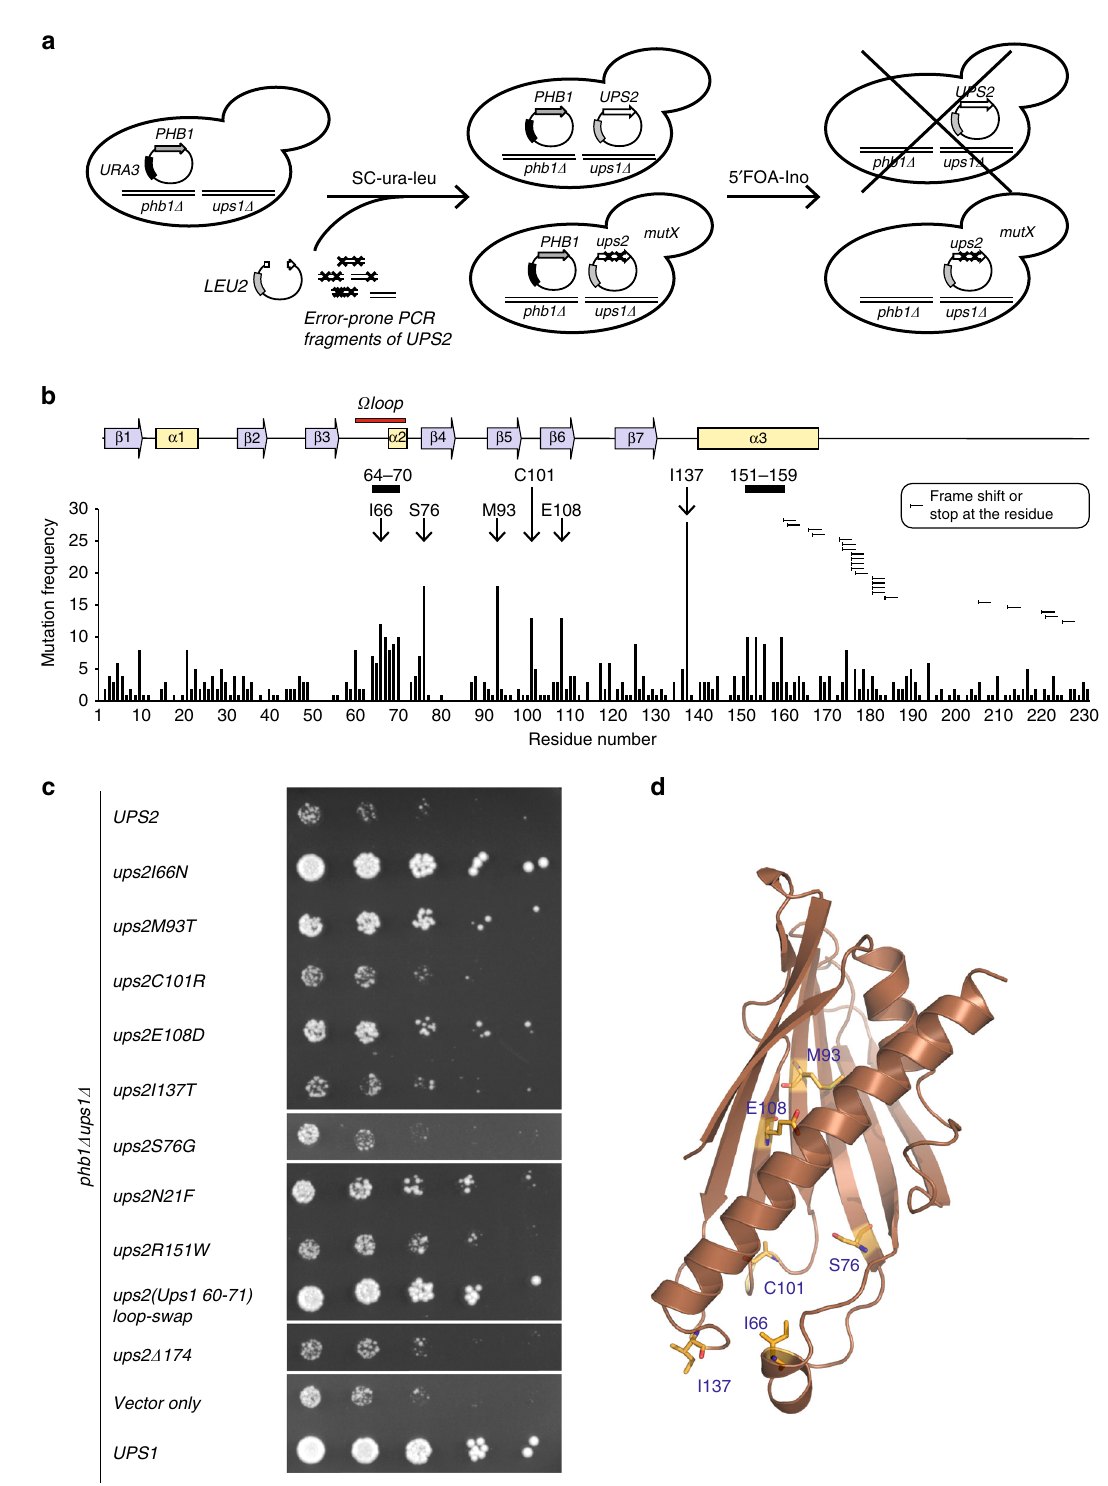
Fig. 5 Identi fi cation of Ups2 variants transferring PA. a Reverse genetic screen for Ups2 variants substituting for Ups1. ups1 Δ phb1 Δ cells harbouring plasmid-borne PHB1 and URA3 were transformed with a linearised yeast plasmid and with PCR fragments of the UPS2 gene that were ampli fi ed by error- prone PCR. The plasmid encoding URA3 was excluded from cells upon growth of the transformants in the presence of 5 ′ FOA. Cells were grown in the absence of inositol to further suppress the growth of the host strain. Plasmids encoding Ups2 mutants were isolated from growing cells and sequenced. b The frequency of mutations in Ups2 variants. Amino acids that were found mutated in >10 Ups2 variants are highlighted. Secondary structure elements in Ups2 are shown. c Growth of ups1 Δ phb1 Δ cells expressing myc-tagged Ups1, Ups2 or the indicated Ups2 variants on selective, inositol-free medium containing glucose and 5 ′ FOA. d Structural model of Ups2 (based on the PRELID3b) with amino acids highlighted that were found to be most frequently